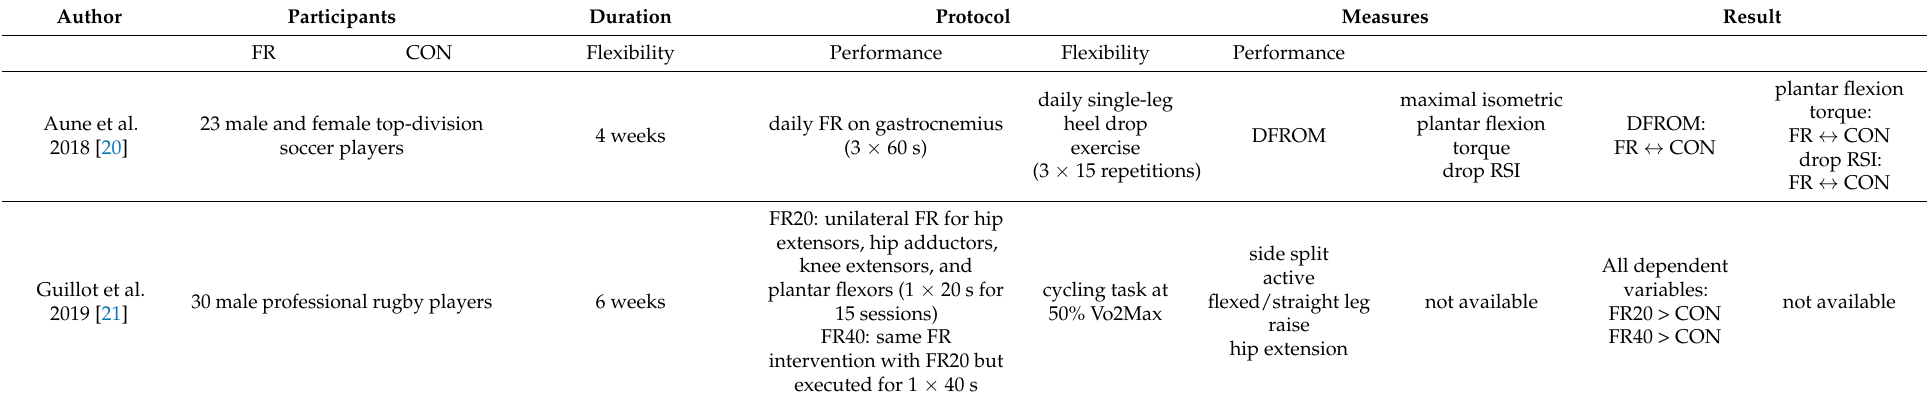
Table 2. Chronic Effects of FR on Flexibility and